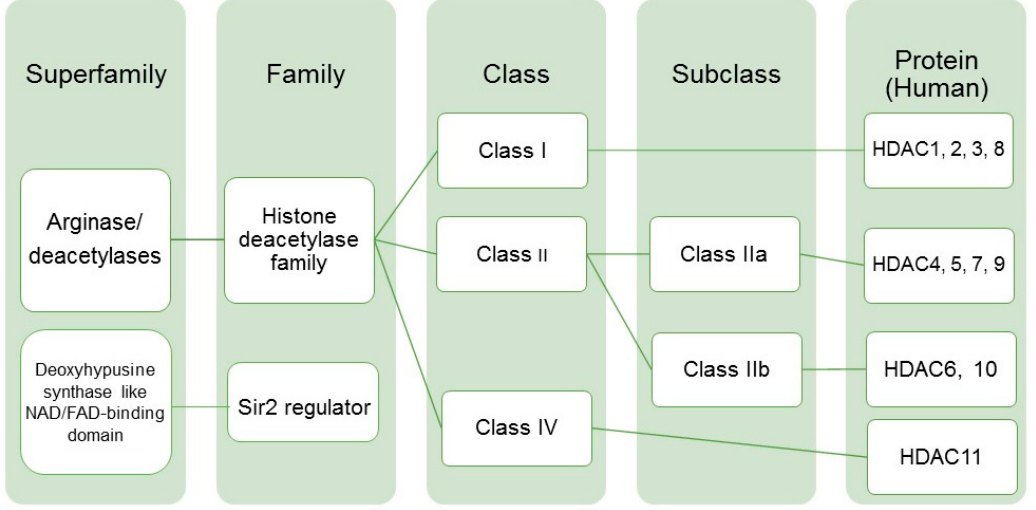
Figure 1. Histone deacetylase family/classes of proteins and expression in human bladder cancer tumors. Histone deacetylase family and respective classes and subclasses with human specific proteins (reviewed in [19]).